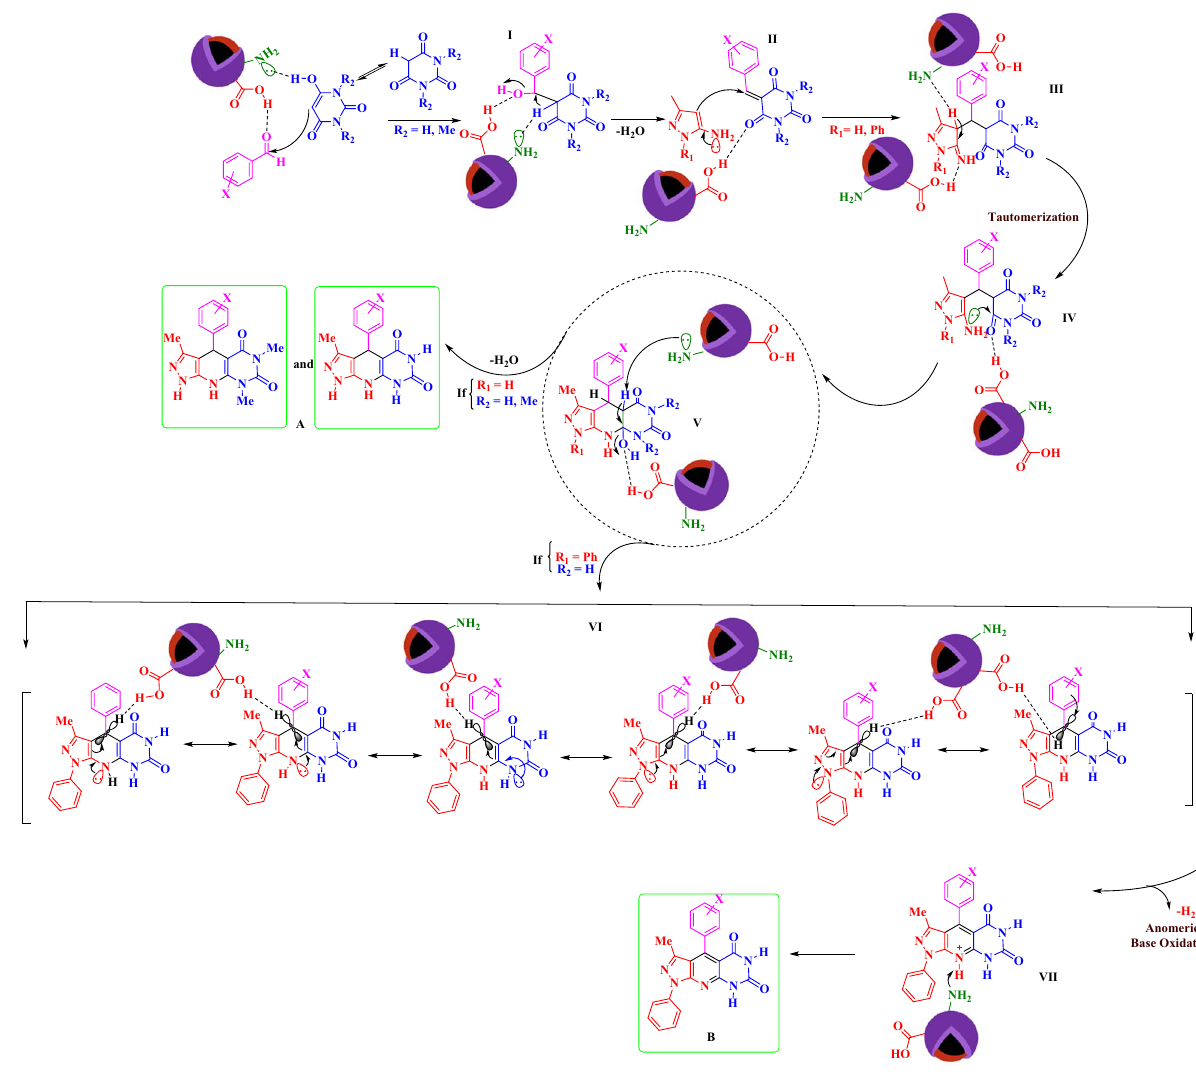
Scheme 3. Proposed mechanism for the preparation of novel fused pyridines and 1,4-dihydropyridines with pyrazole and pyrimidine moieties via a cooperative vinylogous anomeric based